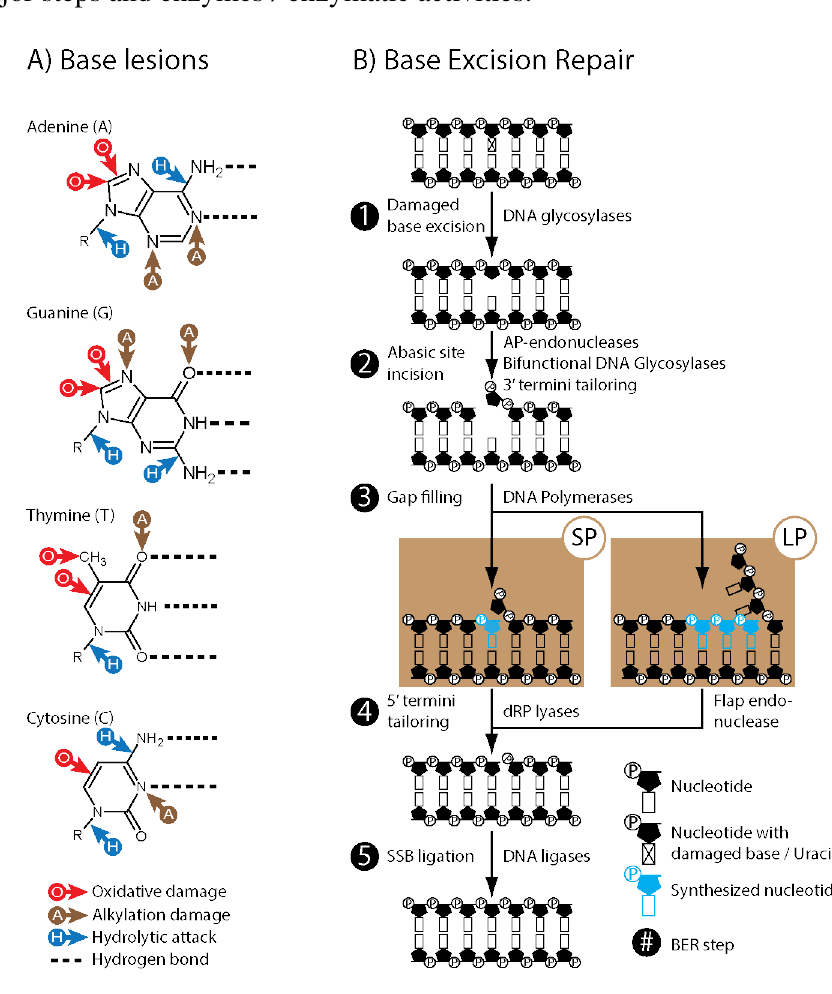
Figure 1. Base lesions and BER summary. ( A ) Base lesions: Typical sites of oxidation (red arrow marked O), alkylation (brown arrow marked ( A ) and spontaneous hydrolysis (blue arrow marked H) within adenine, guanine, thymine and cytosine; ( B ) Base Excision Repair: 1 to 5 major steps and enzymes / enzymatic